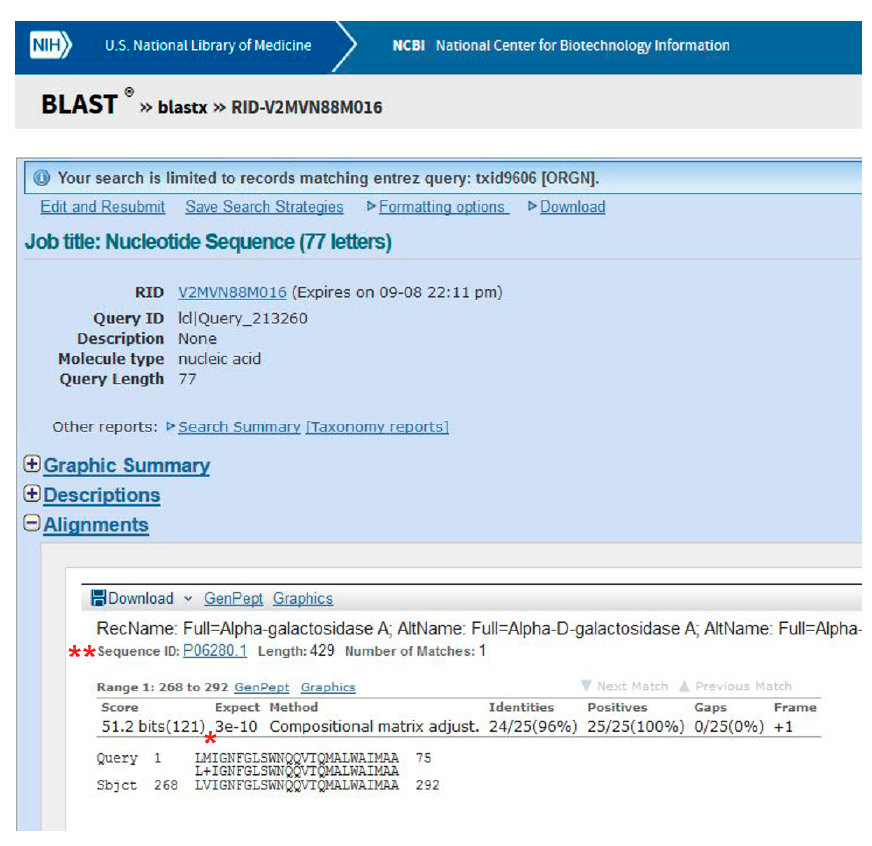
Figure 2. Alignment of the patient’s sequence with the wild-type protein sequence using BLAST. A missense mutation in α -galactosidase A (AGAL) was identified (*). The sequence ID is also highlighted (**).